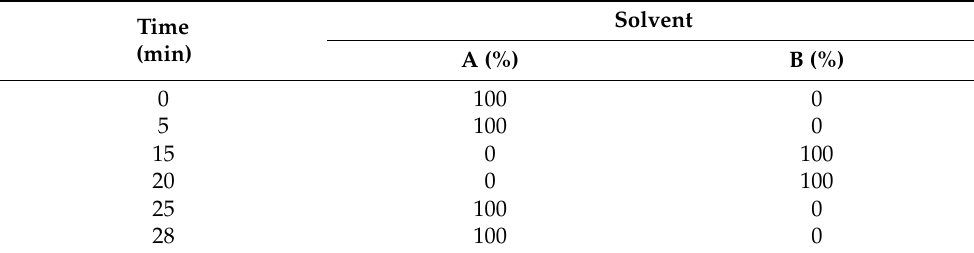
Table 1. Solvent gradient program for the analysis of nicotine in vivo distribution using water ( A ) and 20% water in acetonitrile ( B ), both with 0.18% formic acid and 0.15% triethylamine ( v / v